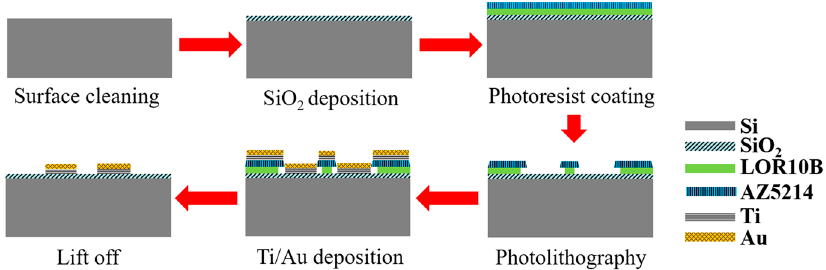
Figure 1. Schematic diagram of gold-film temperature sensor processing flow.